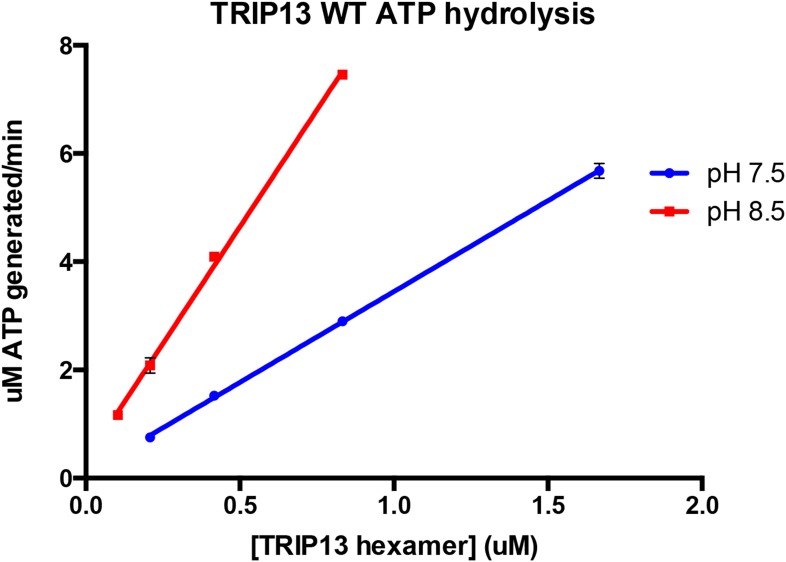
DOI:
http://dx.doi.org/10.7554/eLife.07367.022